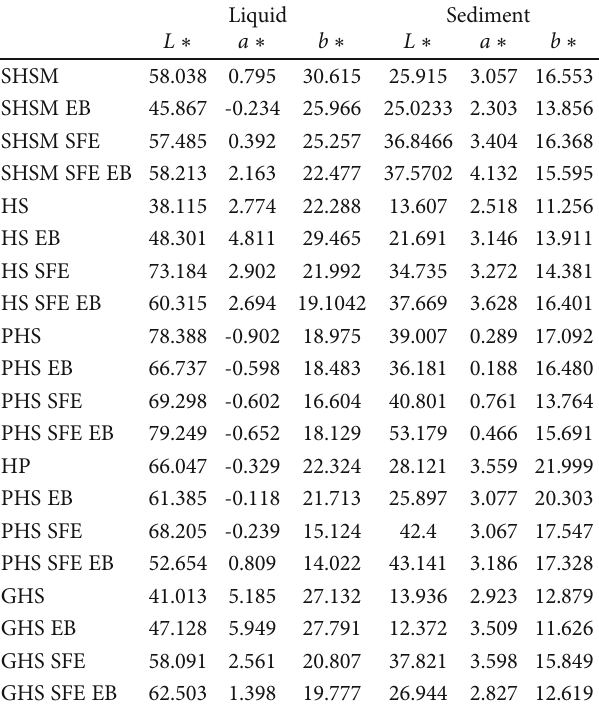
Table 3: Colour pro fi les of the processed hempseed materials. The colour pro fi les were measured from hempseed samples using the L ∗ a ∗ b colour space.